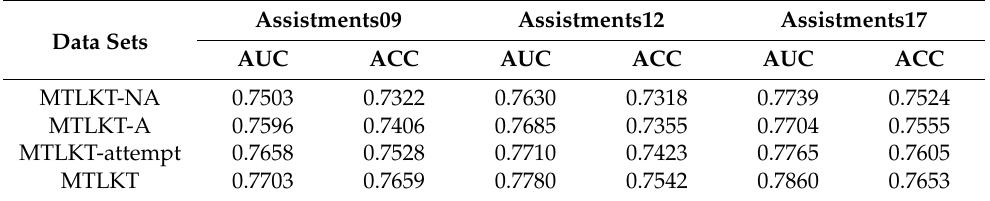
Table 8. Student ability extraction module ablation results.